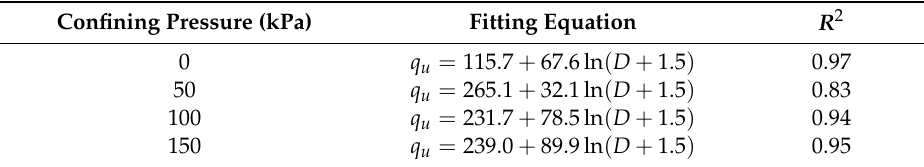
Table 3. Fittings of compressive strength and curing time under di ff erent confining